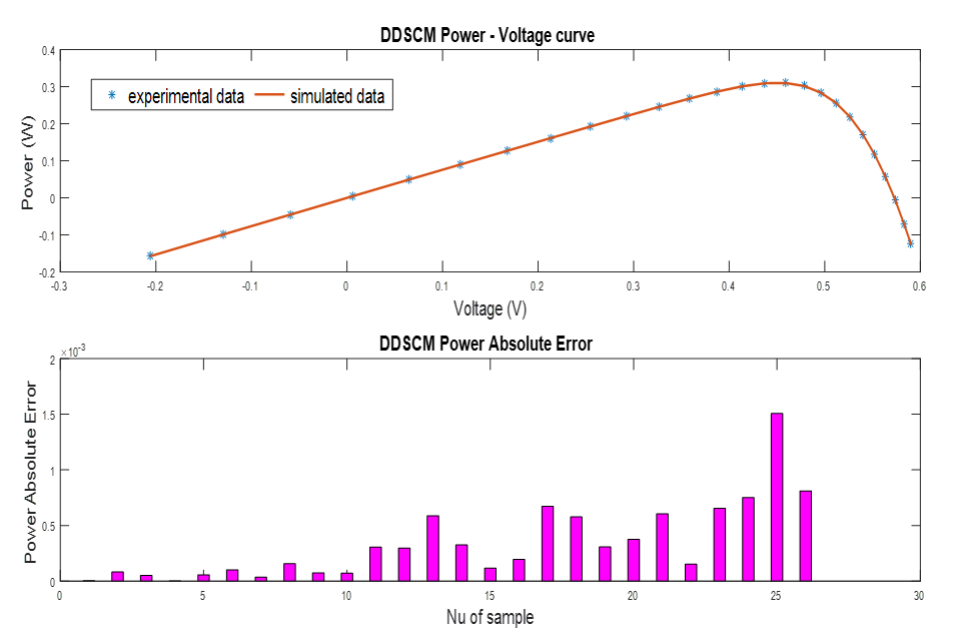
Figure 7. The P-V curve and power absolute error for DDSCM.